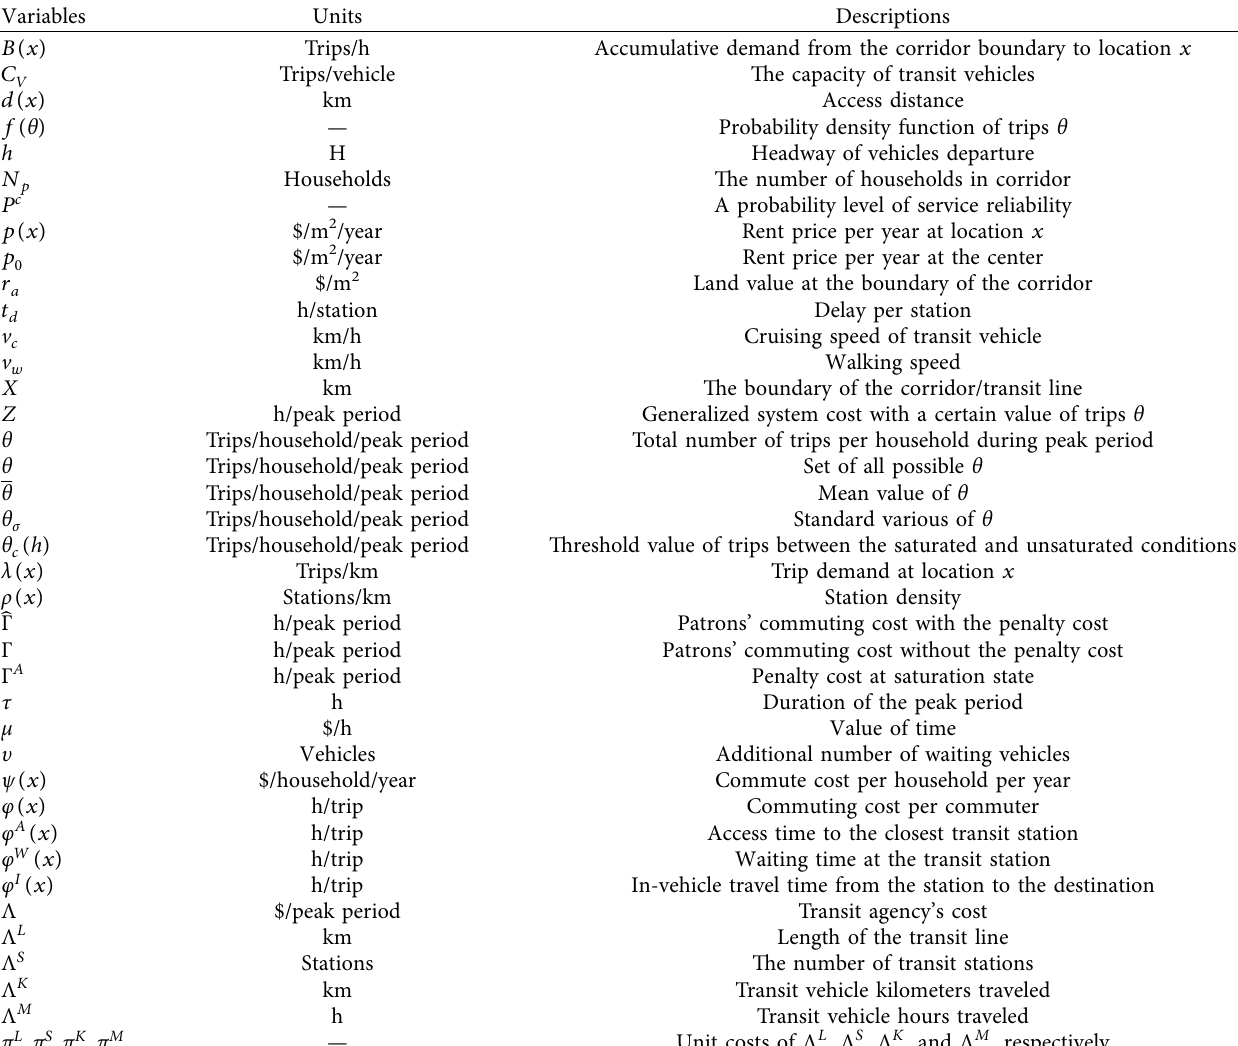
Table 1: Key notations mentioned in the